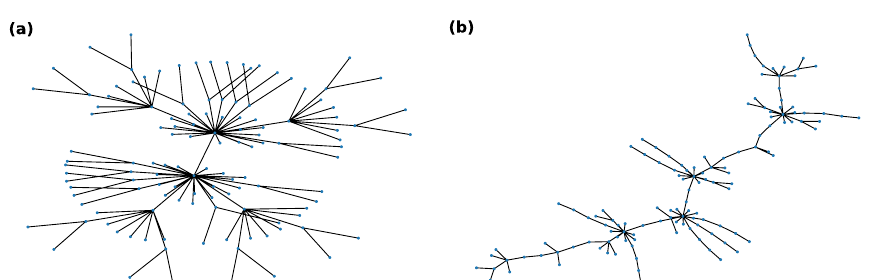
Fig. 2 Illustration of the Song‑Havlin‑Makse model with parameter settings a m = 2, p = 0 , b m = 2, p = 0.6 . In both cases, three iteration steps were made